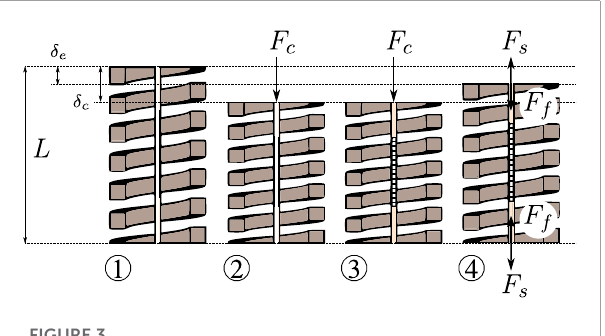
FIGURE 3 Illustration of the MCF pre-straining steps: ① the spring is fixed at the base and is initially free and unloaded, ② a longitudinal calibration force F c is applied at the spring’s end, ③ the MCF is inserted into the spring and fixed at both ends with appropriate adhesives (the longitudinal calibration force F c is still being applied at the spring’s end), ④ once the adhesive is fully cured, i.e., the end-points fixations are rigid, the longitudinal calibration force F c is removed and the spring extends to an equilibrium